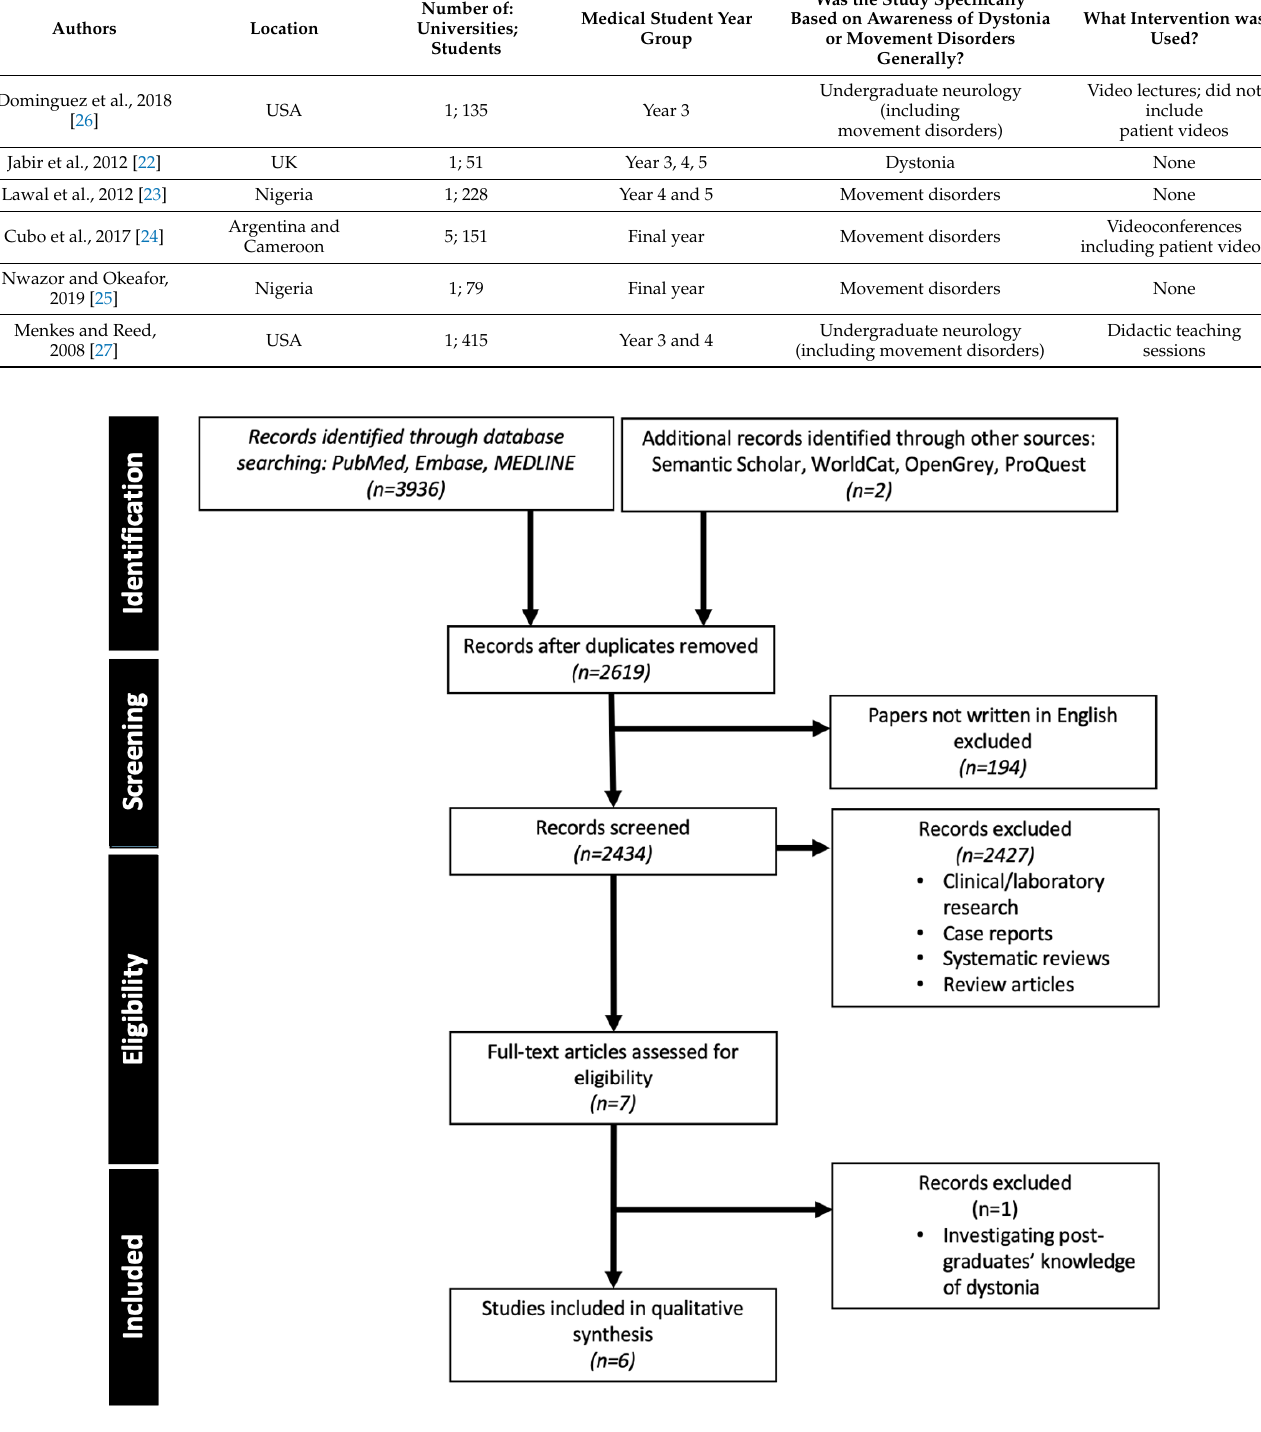
Table 1. Characteristics of the studies included within the systematic review.